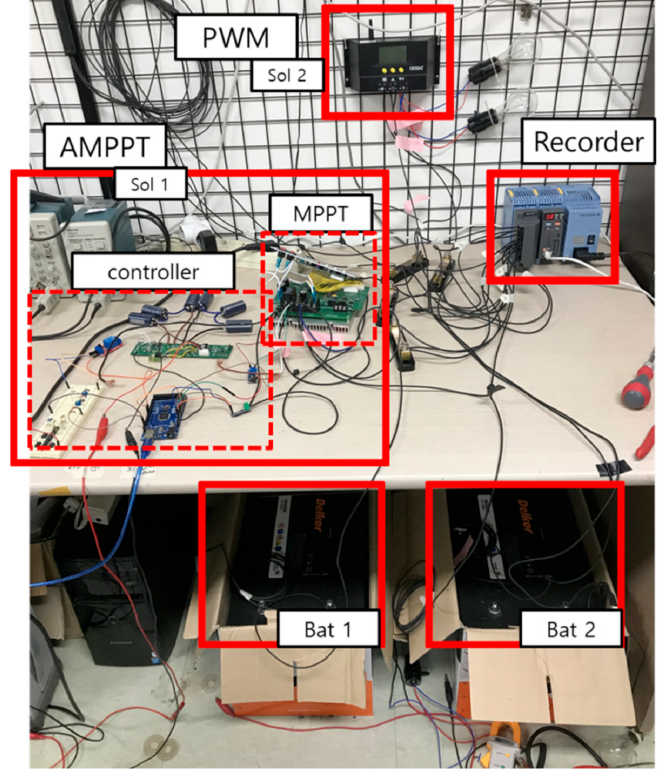
Figure 9. Experiment